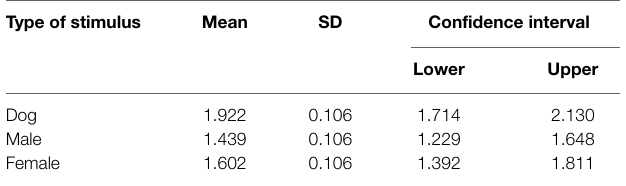
groups with developmental disorders. Pairwise comparisons with sequential correction SIDAK revealed statistically significant differences of TD versus ASD ( p = 0.001) and TD versus ADHD ( p = 0.002). In addition, the ADHD group gazed longer at the mouth region than the other groups. Pairwise comparisons with sequential SIDAK correction indicated significant difference ADHD versus ASD ( p = 0.025), and a trend toward significance between ADHD and TD ( p =